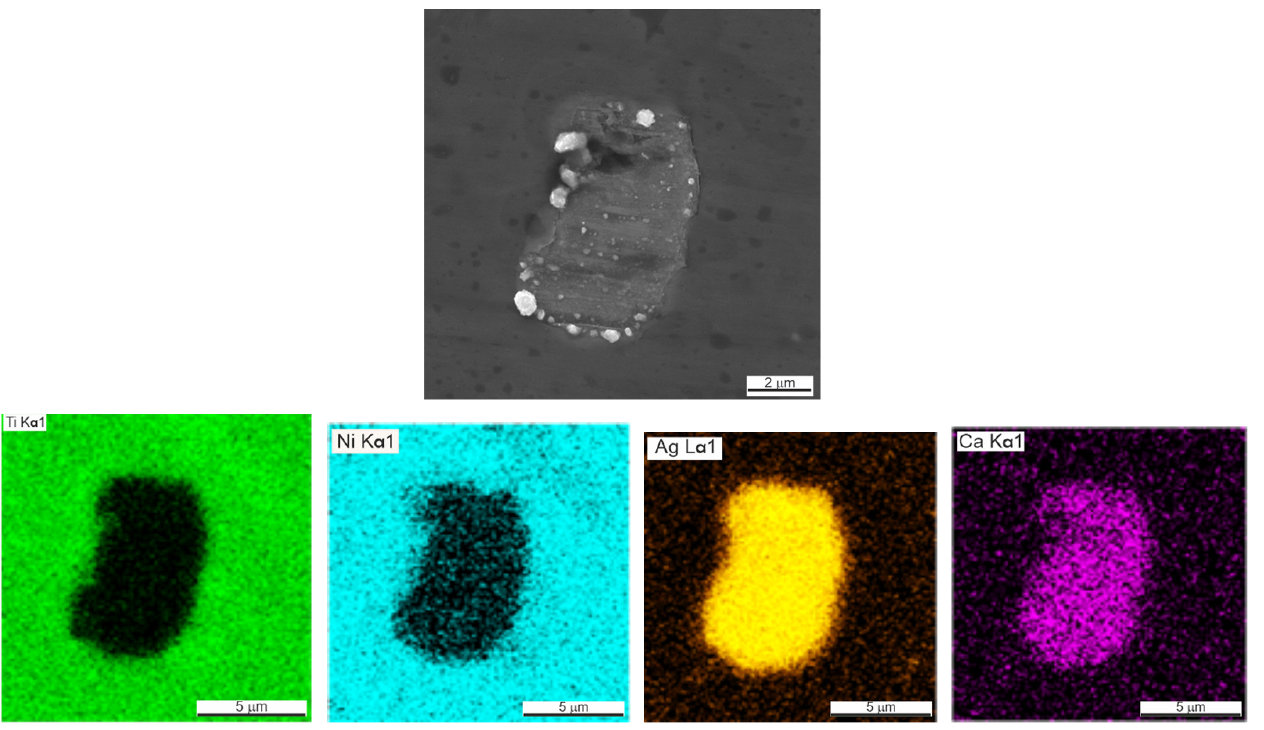
Figure 7. SEM image of the microstructure and EDS mapping of the element composition of the pure silver phase in the porous TiNi + 0.5% Ag alloy.